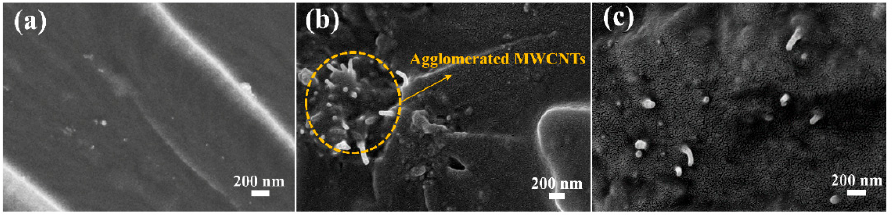
Figure 8. Cross-sectional SEM images for pure CER network ( a ), and for nanocomposites based on CER/MWCNTs ( b ) and CER/uMWCNTs ( c ).